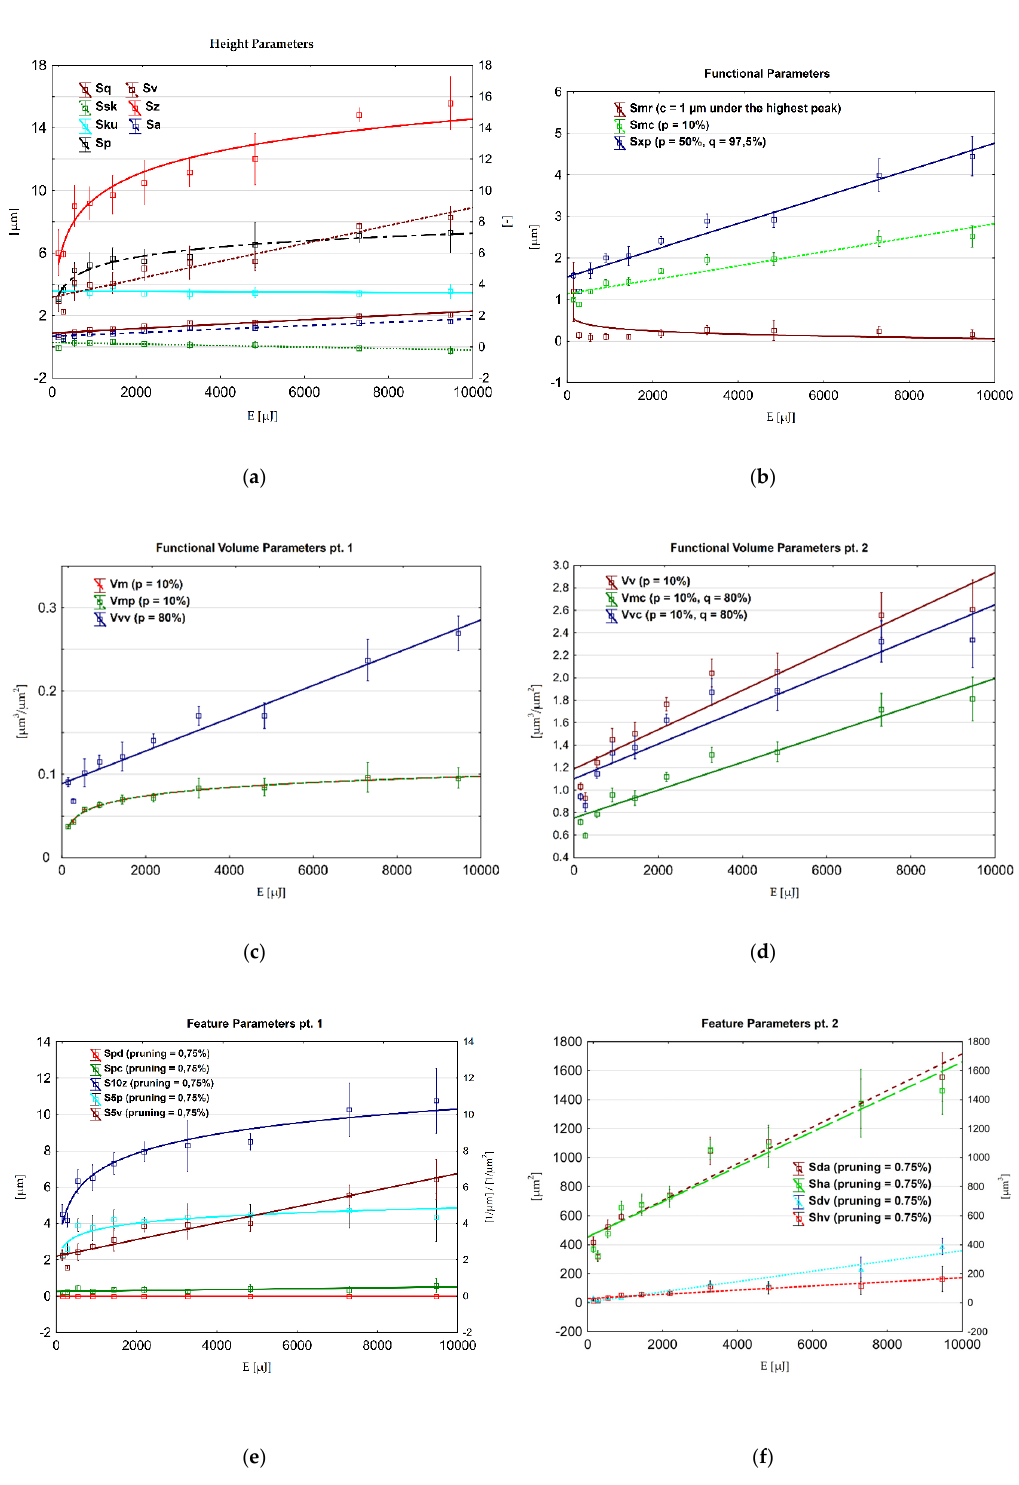
Figure 5. Scatter plots of ISO 25178 areal parameters correlated with discharge energies using linear or logarithmic regression. ( a ) height ; ( b ) functional ; ( c ) and ( d ) functional volume; ( e ) and ( f ) feature parameters.